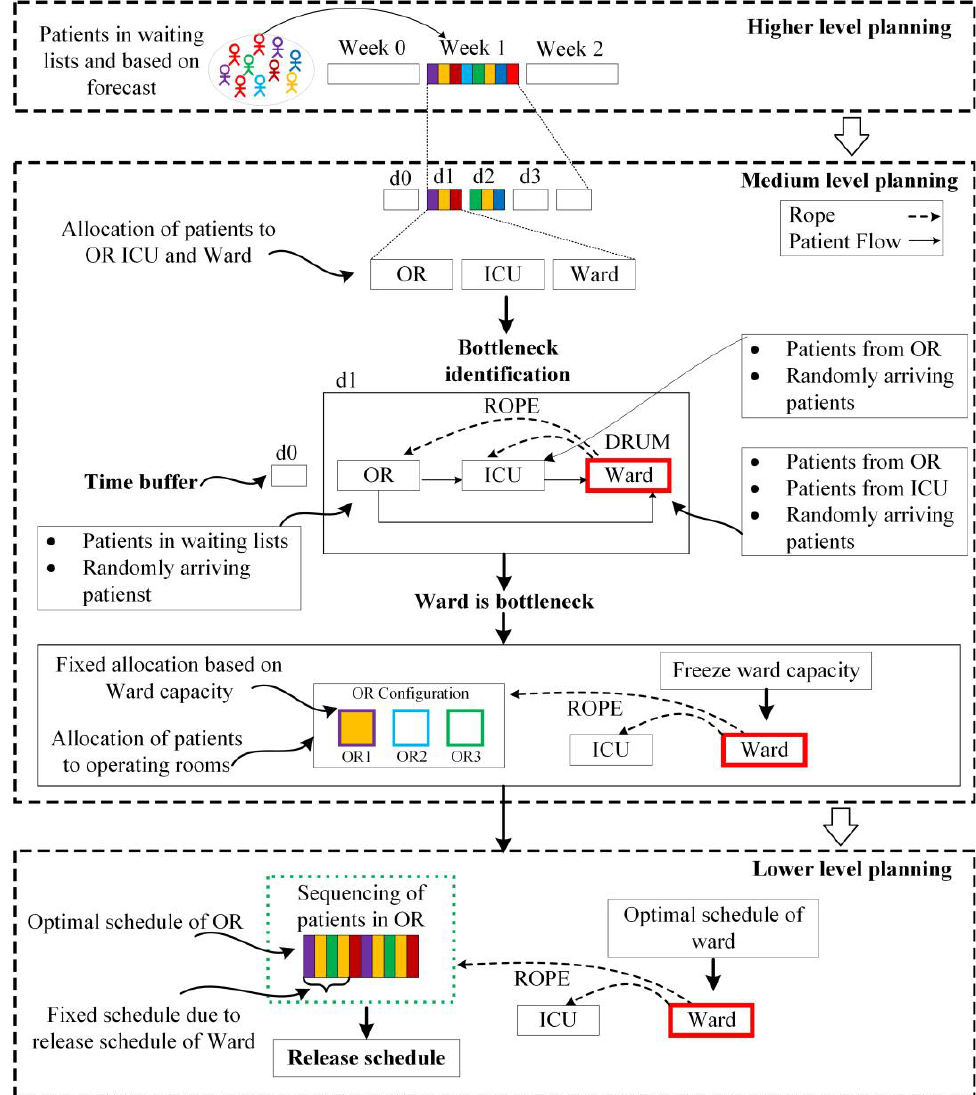
Figure 5. Multi-level integrated planning when the ward is the